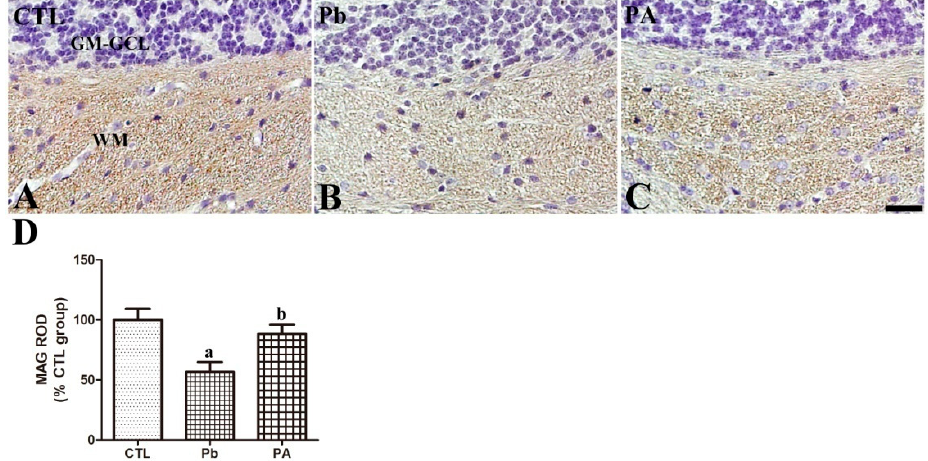
Figure 5. Immunohistochemistry for myelin-associated glycoprotein (MAG, brown) in the cerebellum ( A – C ) of offspring from CTL, Pb, and PA groups. Note that the MAG-immunoreactivity in the WM in the cerebellum are reduced in the Pb group, and ascorbic acid treatment ameliorated this reduction in the PA group. GM-GCL (blue), granule cell layer in gray matter. ( D ) The MAG-immunoreactivity in the WM in the cerebellum is expressed as percentages of the value in the CTL group ( n = 12 offspring per group; a p < 0.05, indicating a significant difference compared with the control group, b p < 0.05, indicating a significant difference compared with the Pb group). The bars indicate the means ± standard errors of the